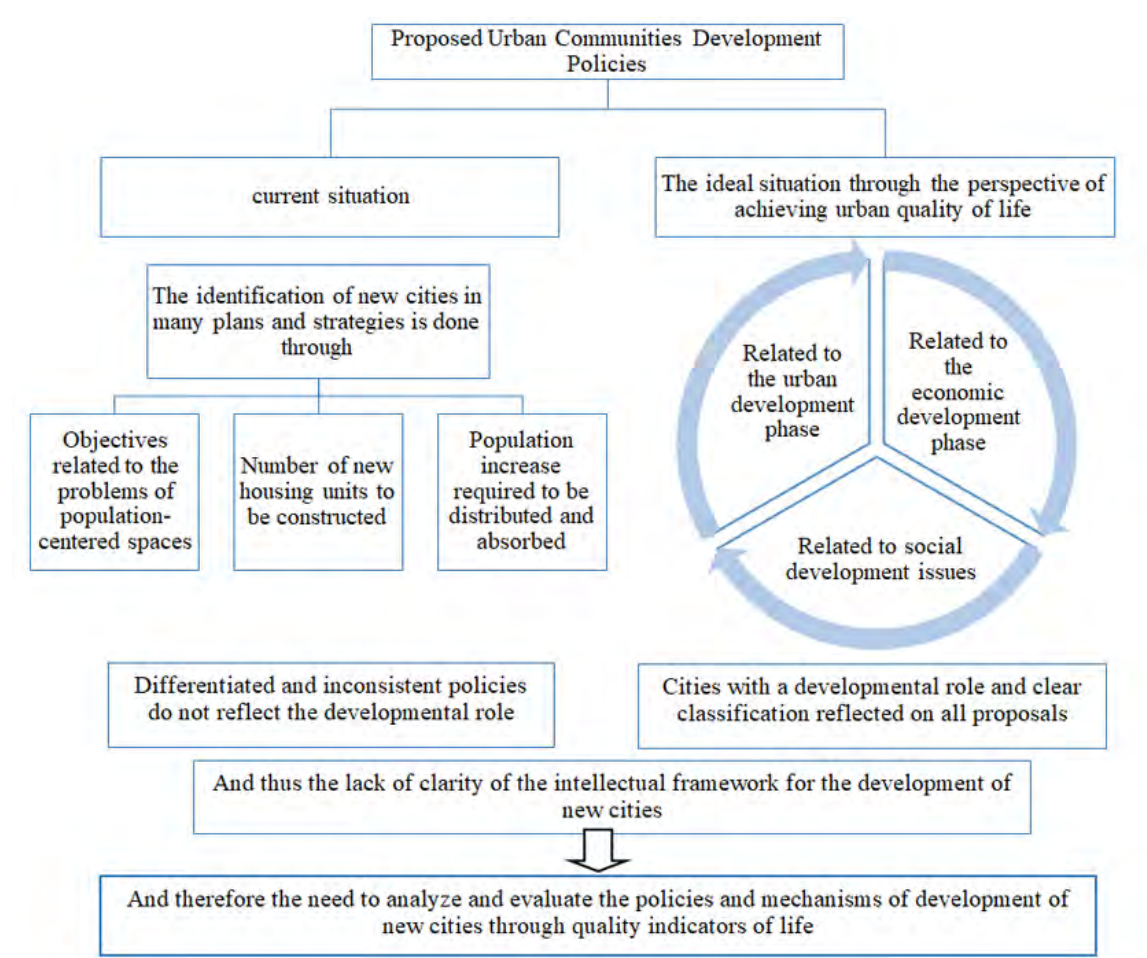
Figure 7. Proposed urban communities development polices